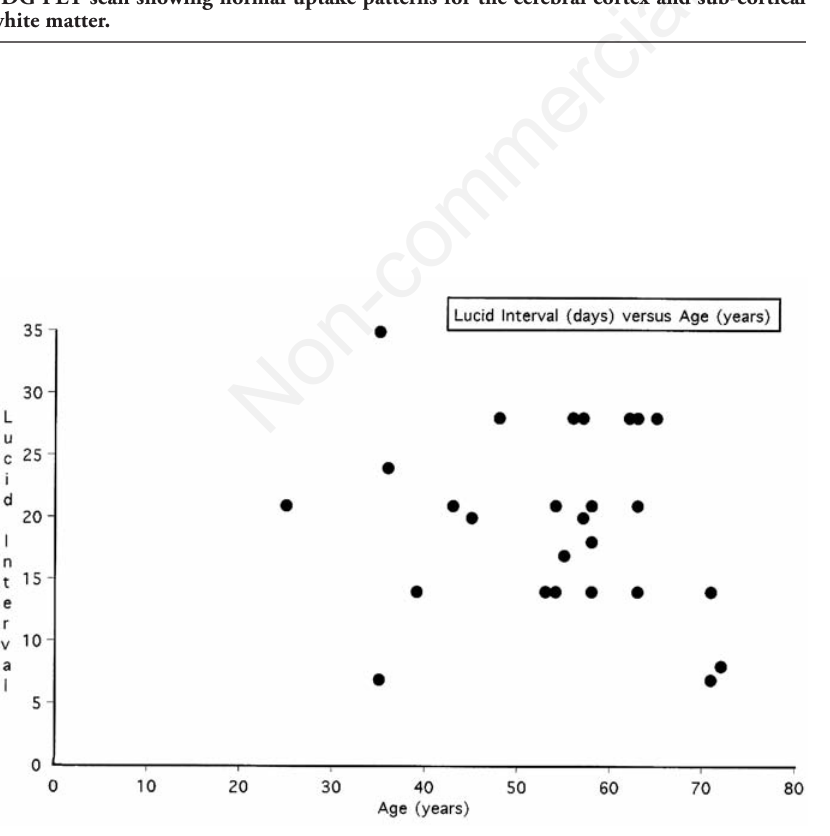
Figure 4. Retrospective review of lucid interval in days (y-axis) in relation age in years (x- axis) for delayed post hypoxic leukoencephalopathy cases from references four through nine, along with the current